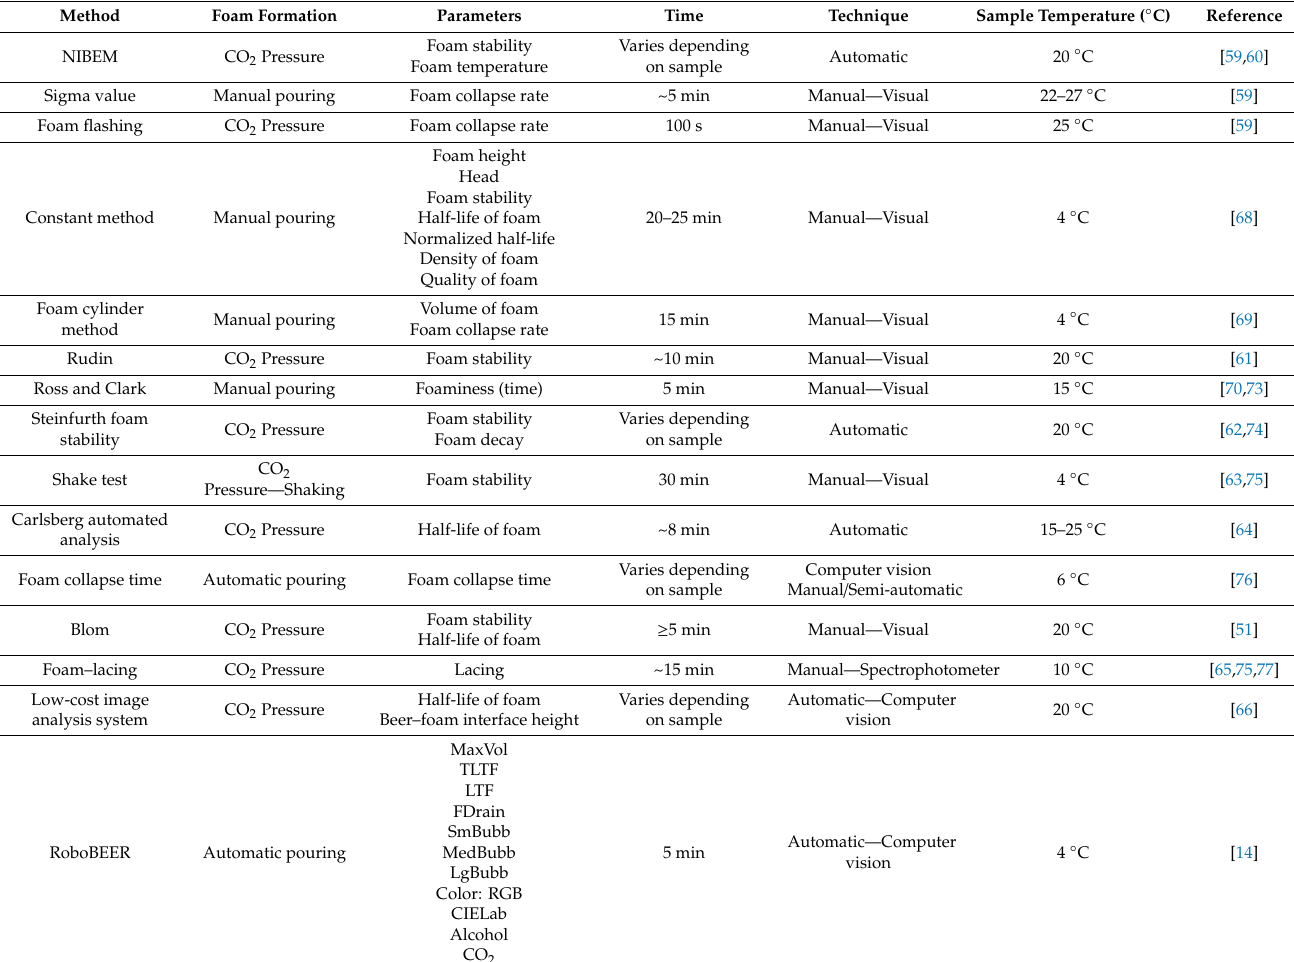
Table 1. Methods to assess foam-related parameters in beer and their working